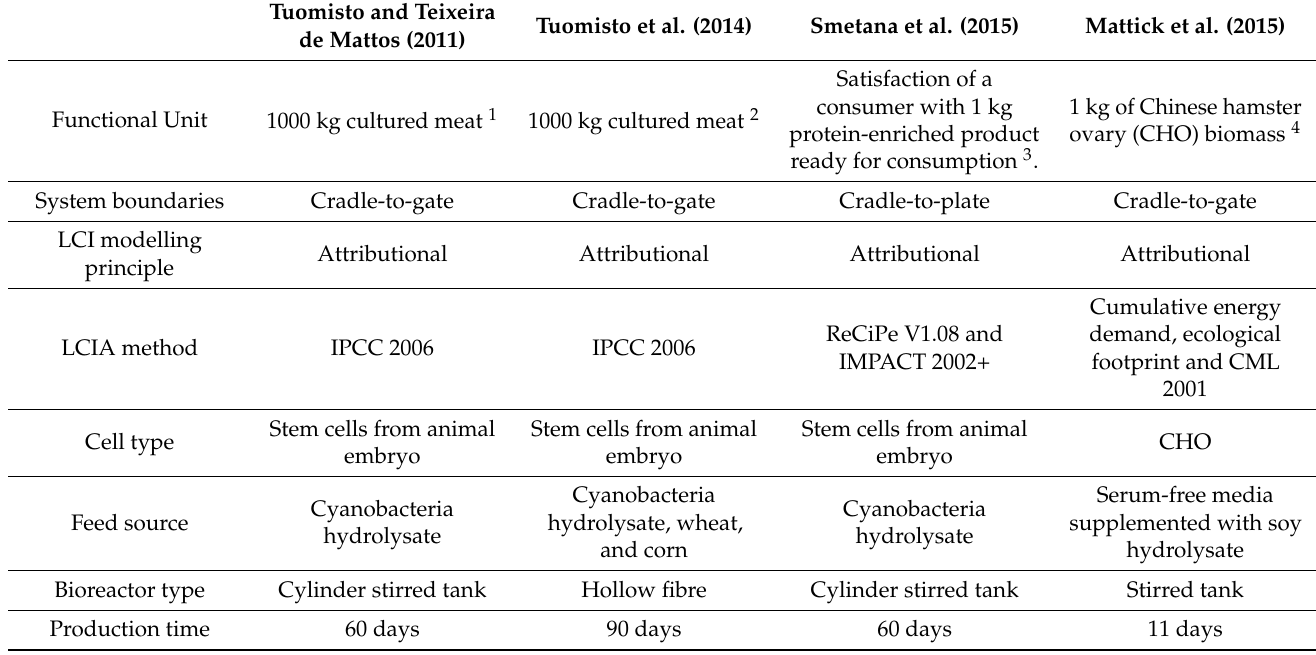
Table 1. Life-cycle assessment and operational parameters of the analysed studies.